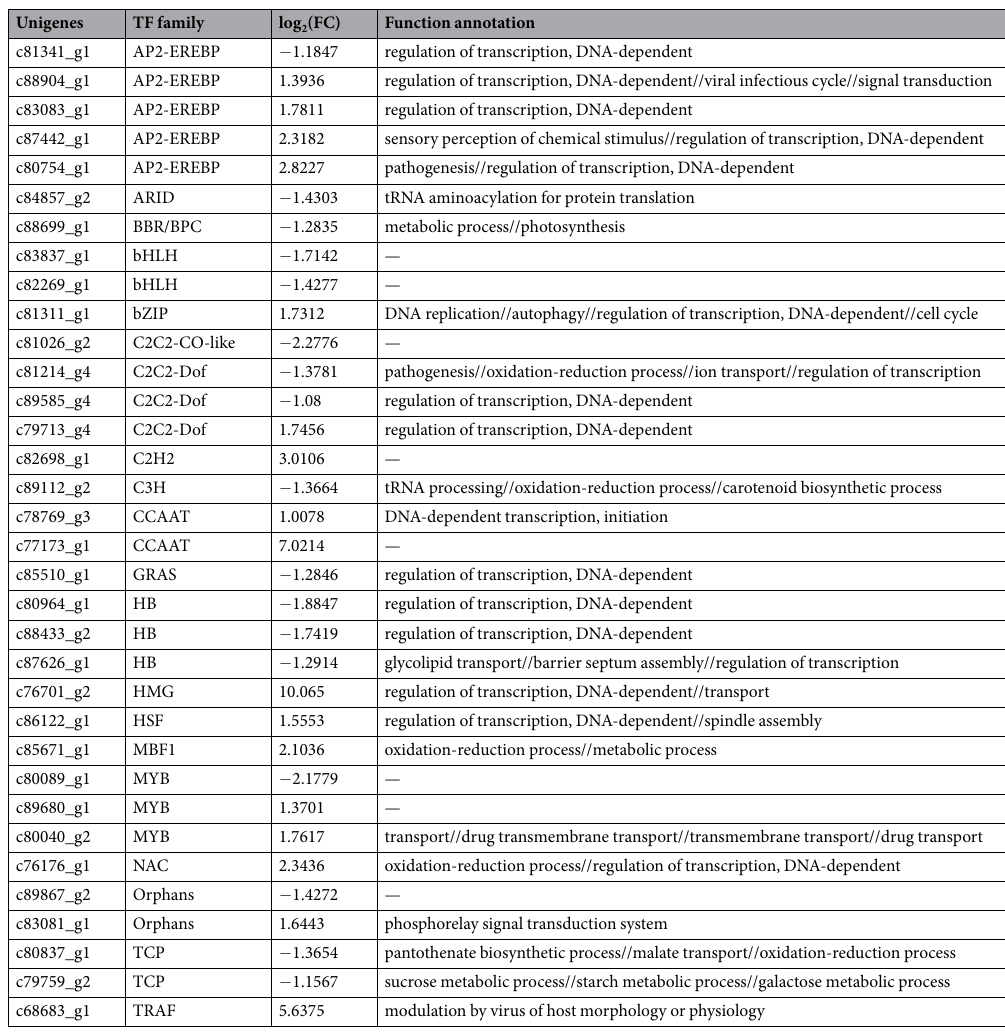
Table 4. Expression and function annotation of 34 differentially expressed genes (DEGs) encoding transcription factors (TFs) in drought-sensitive Corchorus capsularis . FC: fold